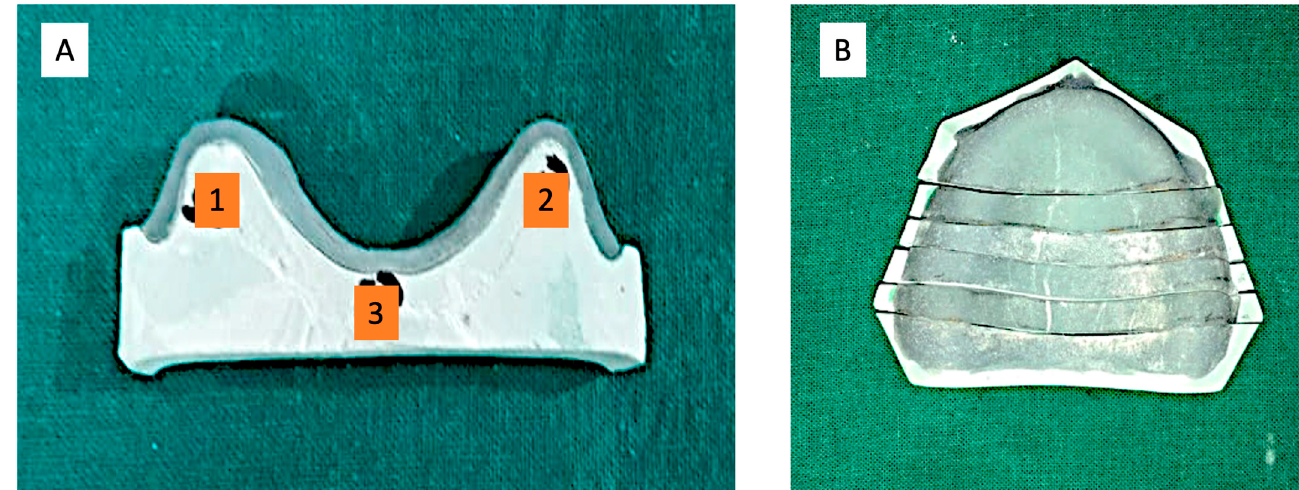
Figure 5. Sectioning & Marking of the Cast & Record Base Assembly ( A ) Coronal section view (1– right ridge crest; 2–left ridge crest and 3–mid-palate region); ( B ) Occlusal view